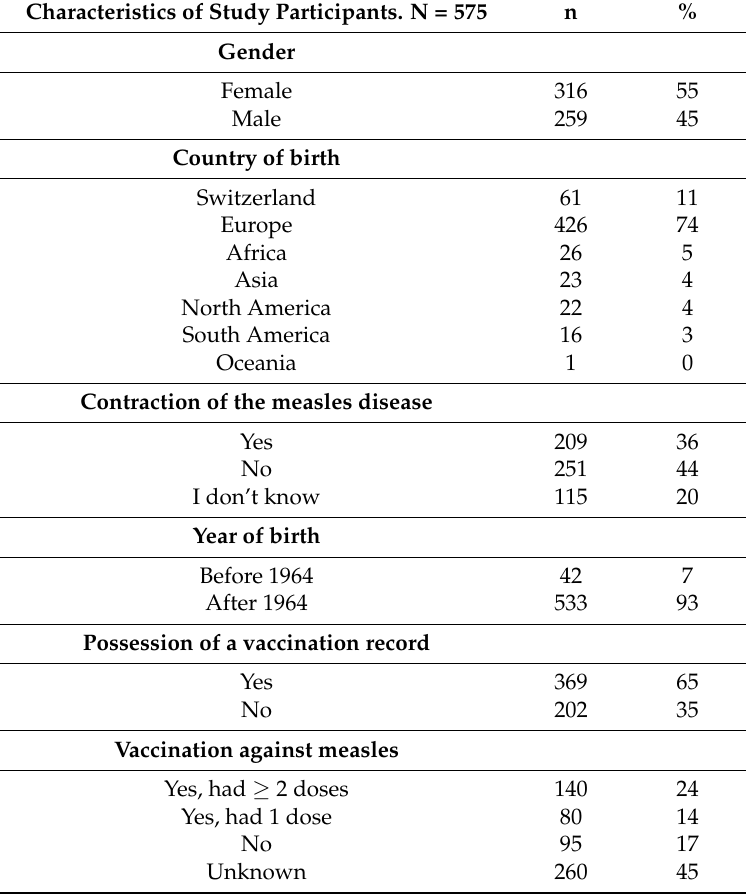
Table 1. Participants’ socio-demographic